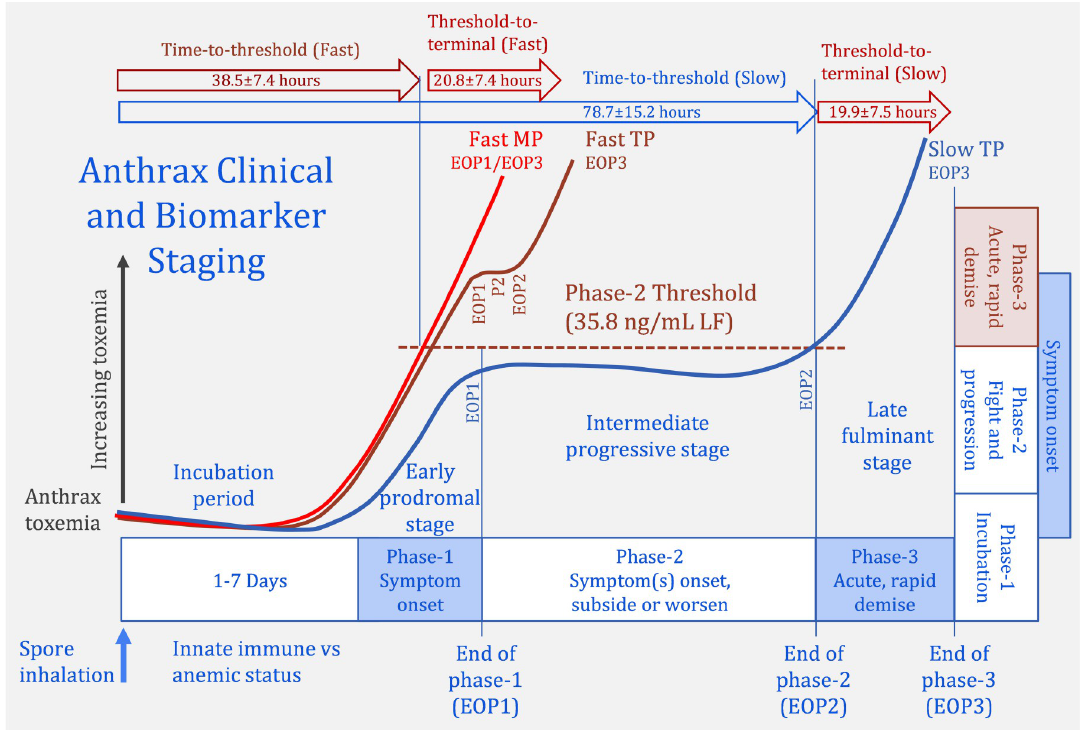
Fig 7. Proposed relationship of toxemia-defined progression with clinical staging. The triphasic (TP) kinetics of anthrax toxemia with slow progression in non-human primates mirrors the clinical staging algorithm. A brief incubation period is followed by 1) the early-prodromal stage 1 with the onset of non-specific symptoms which coincides with the early rise in toxemia to the end-of-phase-1 (EOP1). This is followed by 2) the intermediate-progressive stage which coincides with the plateau/decline in toxemia that continues to the end-of-phase-2 (EOP2) when the critical toxemic thresholds are exceeded, which coincides with entry to 3) the late-fulminant stage with a rapid decline in clinical stability and rapid rise in toxemia/bacteremia. Fast progression occurs over a compressed timeline during which the phase-2 plateau may (fast triphasic-TP) or may not be observed (fast monophasic-MP) kinetics. The dependence of progression on toxemia can be seen with the shorter time-to-threshold for fast progression than slow and the similar time from threshold-to-terminal for both. Progression may be reoriented from time/clinical-dependent staging to toxin/clinical-dependent